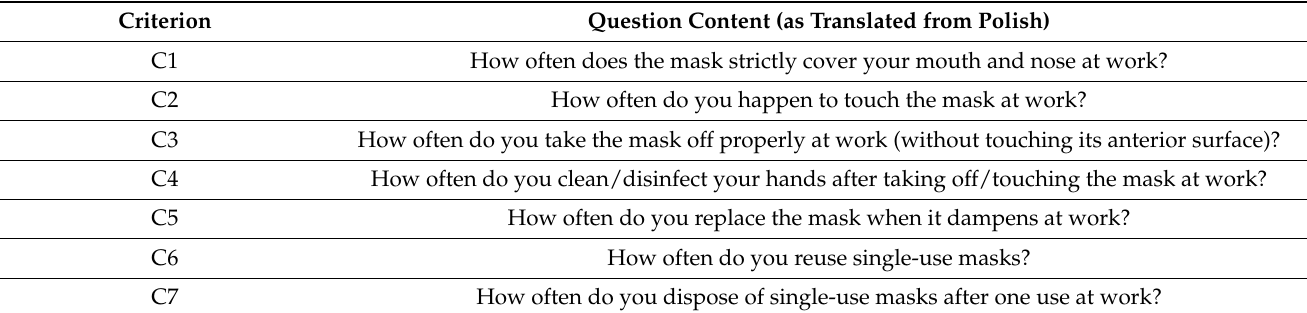
Table 1. The list of questions on the correct use of face masks according to the WHO guidance criteria.